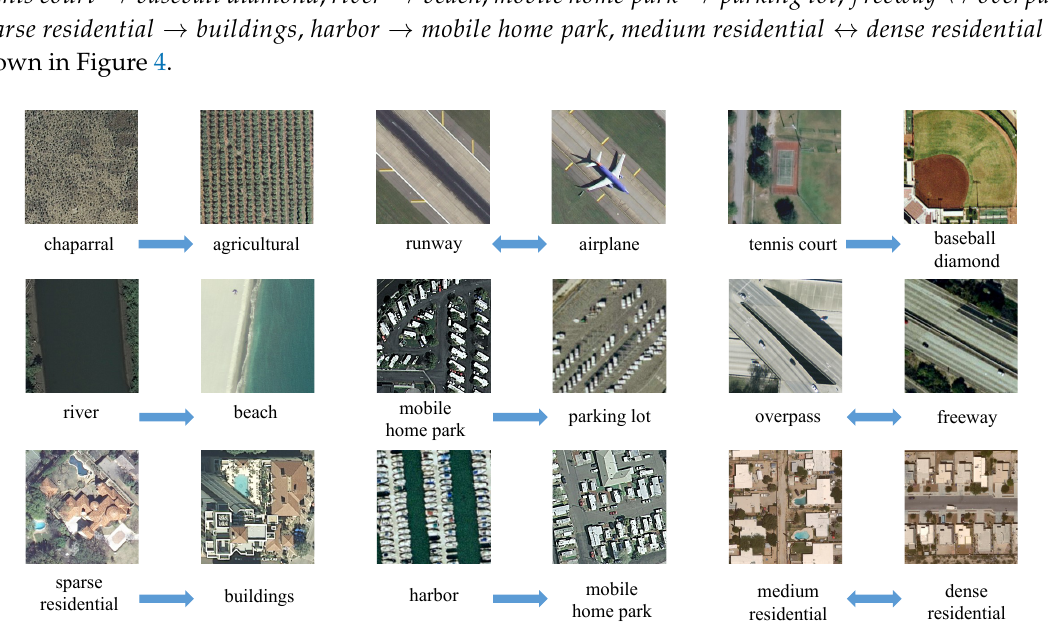
Figure 4. Examples of asymmetric noise mapping scenes in the UC Merced Land-use dataset. For